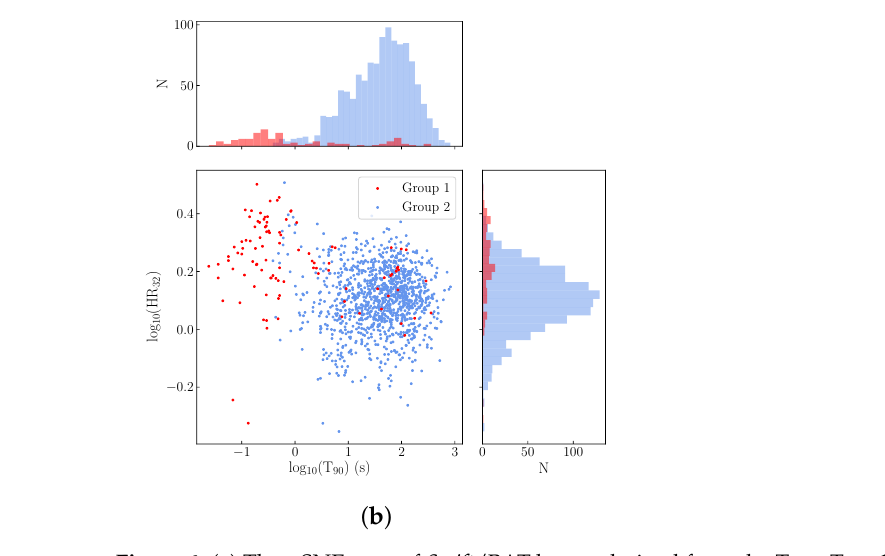
Figure 6. ( a ) The t-SNE map of Swift /BAT bursts derived from the T 0 to T 0 + 1.004s interval at 4ms resolution showing 2 clearly separated groups and ( b ) their projection onto the duration-hardness plane. Histograms indicate the distribution of duration and hardness for each group.